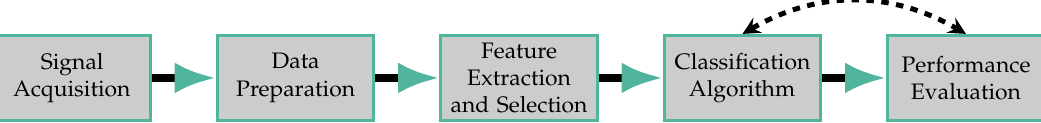
Figure 1. Schematic representation of an Human Activity Recognition (HAR) system